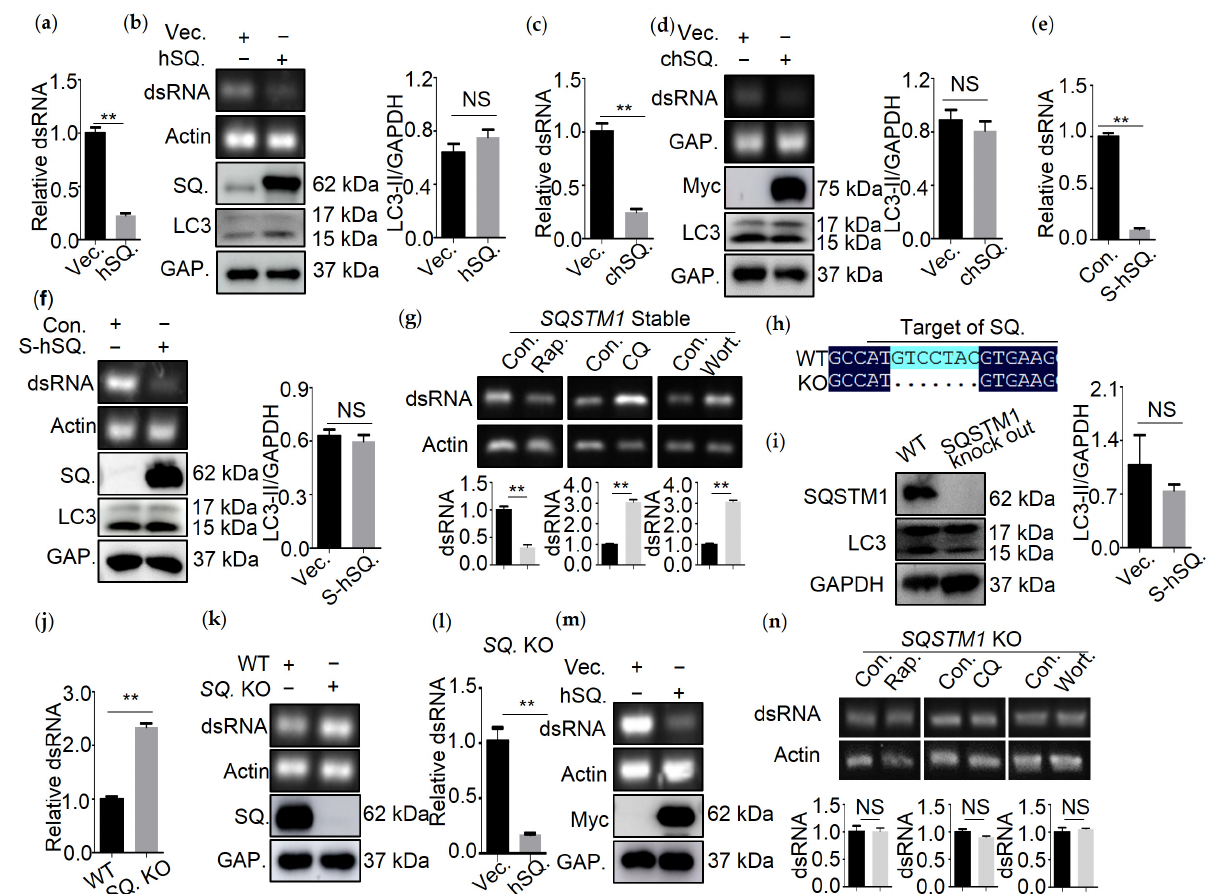
Figure 2. QRT-PCR and PCR analysis of IBDV dsRNA and β -Actin mRNA from 293T cells cotransfected with Myc-tag human SQSTM1 (hSQ) and dsRNA for 8 h ( a , b ), DF-1 cells cotransfected with Myc-tag chicken SQSTM1 (chSQ), and dsRNA for 8 h ( c , d ), stable 293T cells expressing SQSTM1 (S-hSQ) transfected with dsRNA for 8 h ( e , f ), stable 293T cells expressing SQSTM1 (SQSTM1 Stable) transfected with dsRNA for 8 h and treated with Rapa., CQ, Wort. for 4 h before collection ( g ). ( h ) Sequencing analysis of DNA amplified from SQSTM1 genes from SQSTM1 KO cell lines. ( i ) Cell lysates from wild-type (WT) or SQSTM1 KO cell lines were subjected to immunoblotting analysis by using indicated antibodies. QRT-PCR and PCR analysis of IBDV dsRNA and β -Actin mRNA from SQSTM1 knock out (SQ. KO) 293T cells transfected with dsRNA for 8 h ( j , k ), SQSTM1 KO cell lines cotransfected with Myc-tag human SQSTM1 (hSQ.) and dsRNA for 8 h ( l , m ), SQSTM1 knock out (SQSTM1 KO) 293T cells transfected with dsRNA for 8 h and treated with Rapa, CQ, Wort for 4 h before collection ( n ). Data were represented as mean ± SD of three independent experiments. NS, not significant ( p > 0.05); ** p < 0.01.